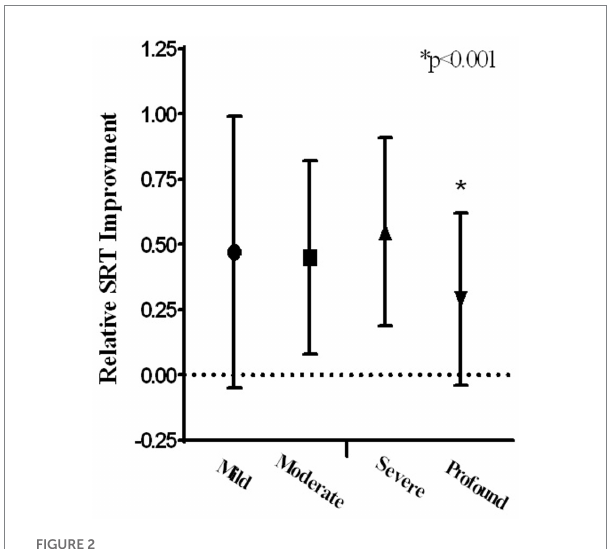
FIGURE 2 Relative SRT improvement according to hearing loss